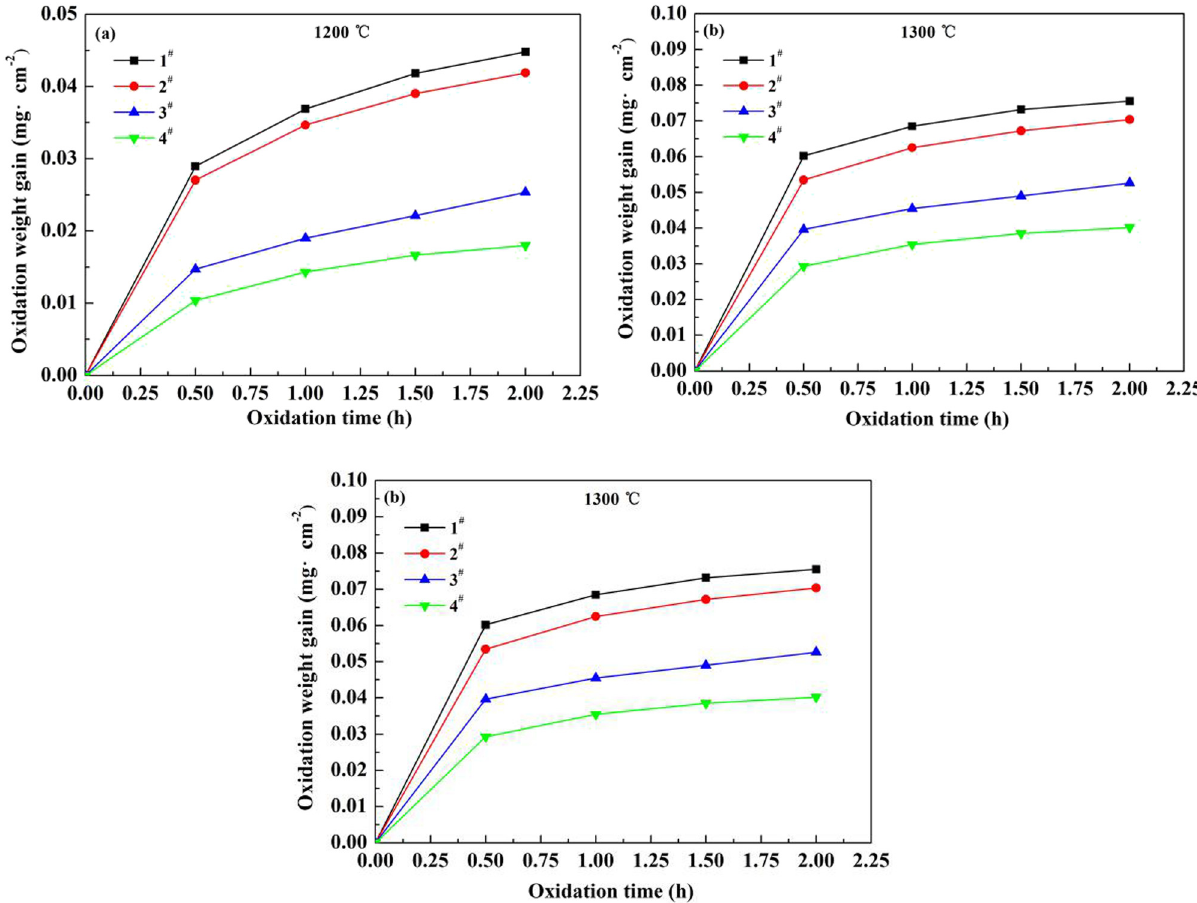
Figure 7: Specific weight gains as a function of oxidation time for Si 4 Al 2 O 2 N 6 powder oxidized at different